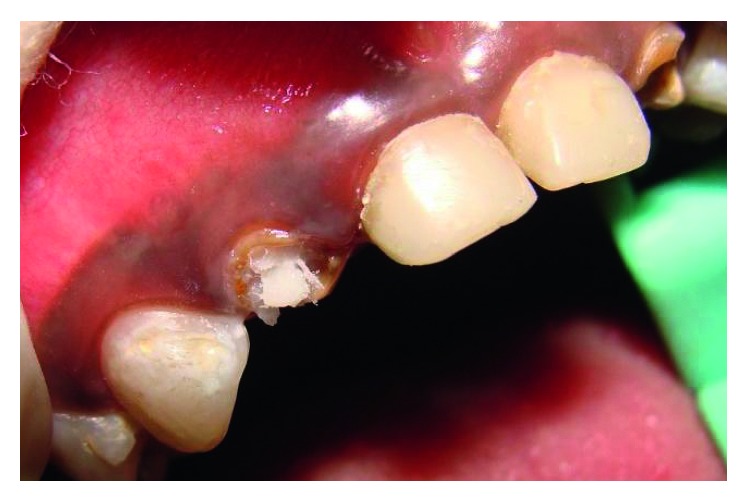
Ribbond post cured.